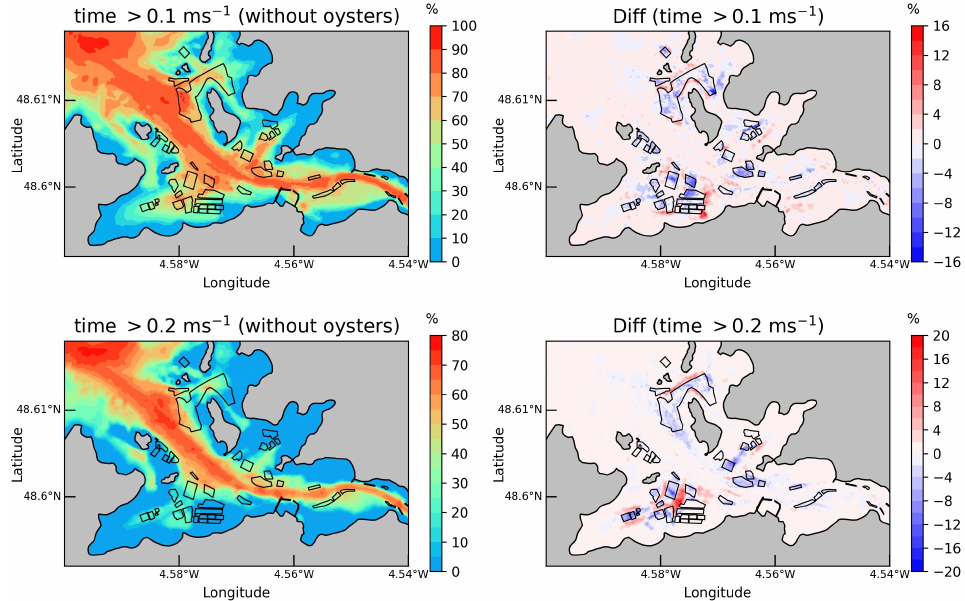
Figure 13. ( left ) Percentage of times for ¯ u > 0.1 ms − 1 and ¯ u > 0.2 ms − 1 during a mean spring tidal cycle in conditions without oyster tables (E 1 ). ( right ) Differences predicted with oyster tables (between simulations E 3 and E 1 ).